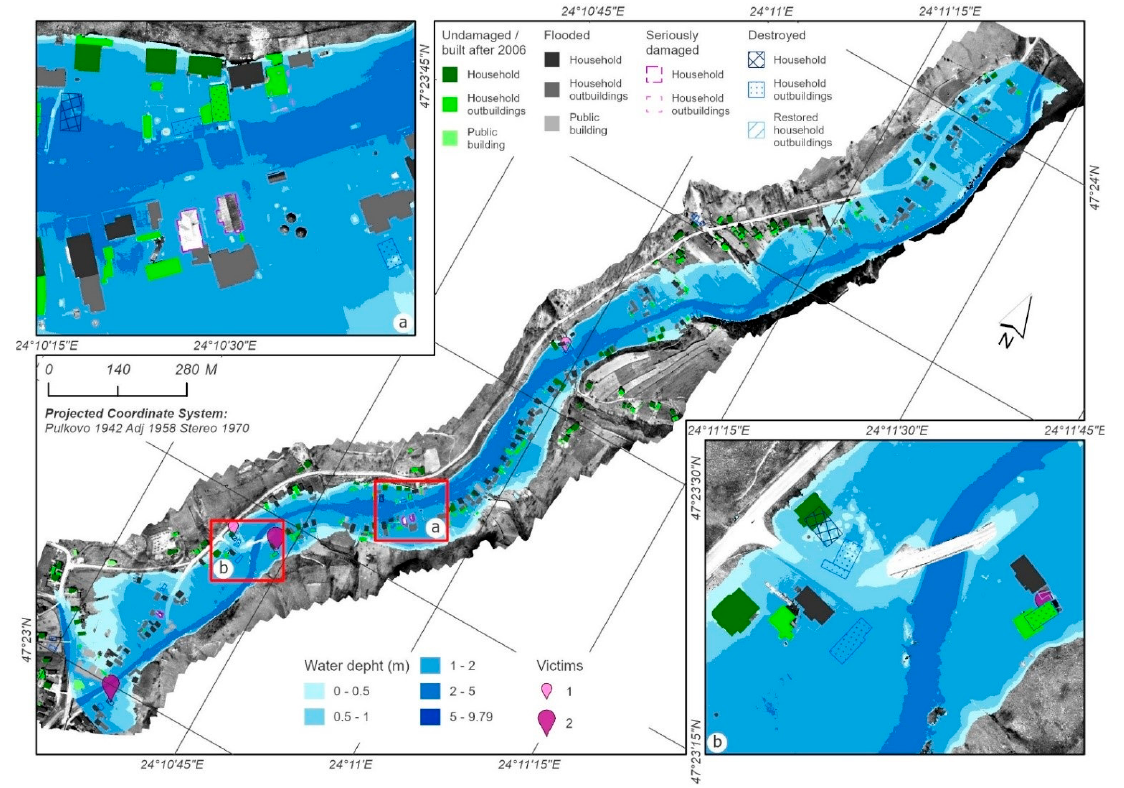
Figure 5. The water height corresponding to the floodable